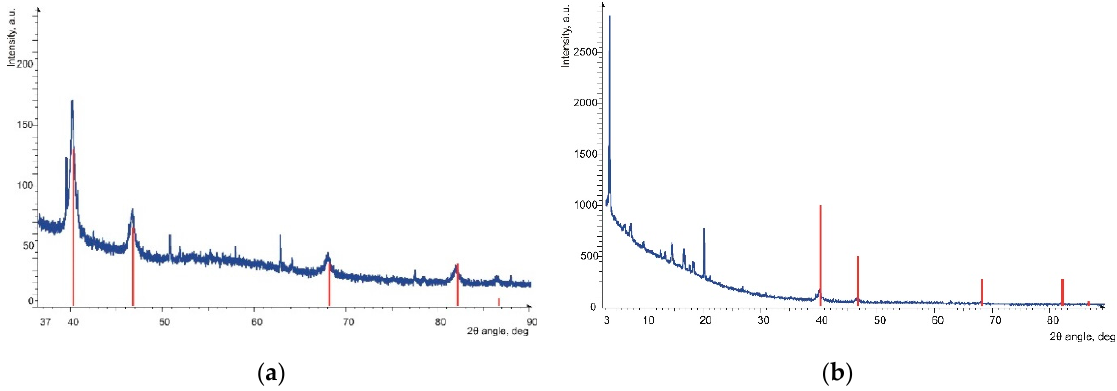
Figure 11. Experimental powder diffraction pattern of a sample PdNPs and 5b in ethanol ( a ); enlarged part of the diffractogram ( b ). Red vertical bars show the positions of the interference peaks corresponding to the crystalline form of palladium Pd, syn., Code No. 00-001-1201.